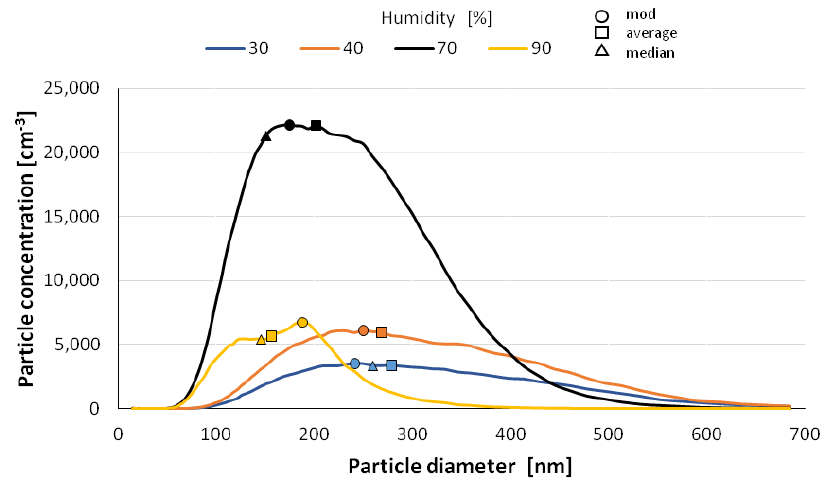
Figure 10. Size distribution of superfine particles 13.5 min after atomization.